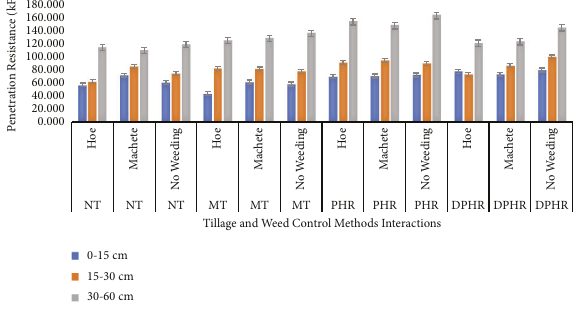
Figure 6: Tillage and weed control methods’ interaction effect on penetration Table 8: Tillage and weed control methods’ interaction effect on bulk density, moisture content, and penetration resistance.